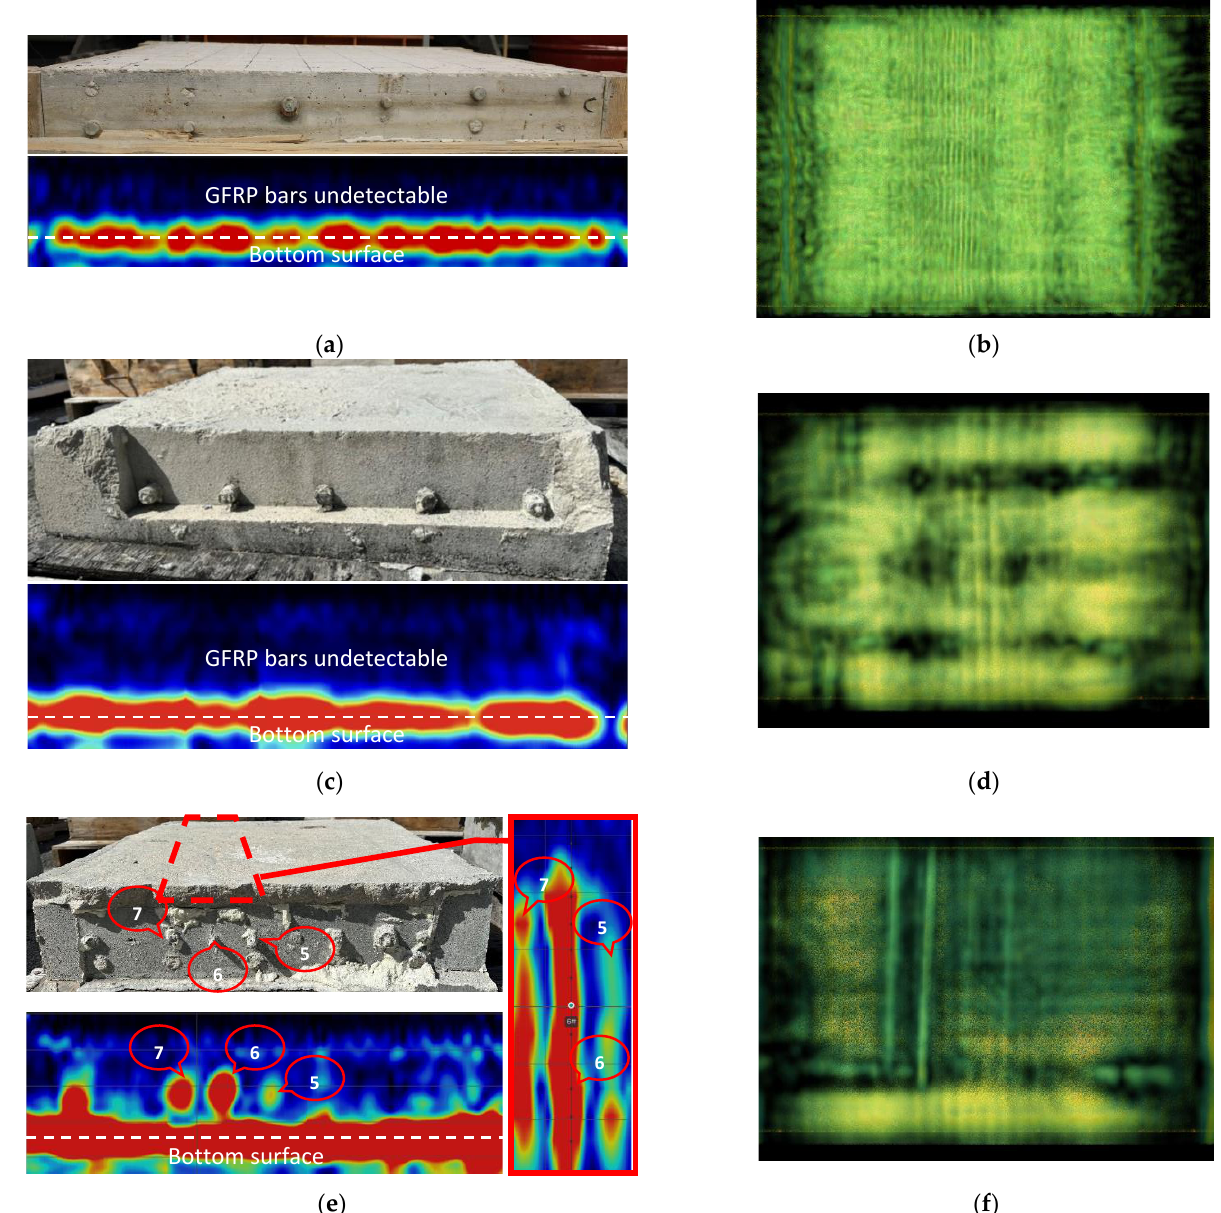
Figure 11. PAU test results: ( a ) Slab C line scan using Pundit, ( b ) Slab C area scan using MIRA 3D, ( c ) Slab J line scan using Pundit, ( d ) Slab J area scan using MIRA 3D, ( e ) Slab L line scan and stripe scan using Pundit, ( f ) Slab L area scan using MIRA 3D